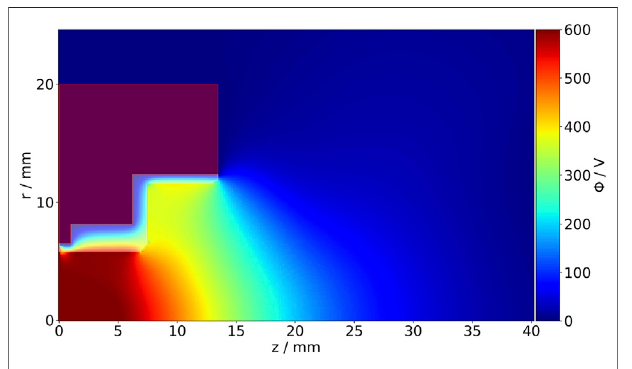
FIGURE 3 | Electron (e) density distribution of the 2D axisymmetric PIC simulation for the MS4. The metal casing (transparent red) and dielectric (transparent white) are also